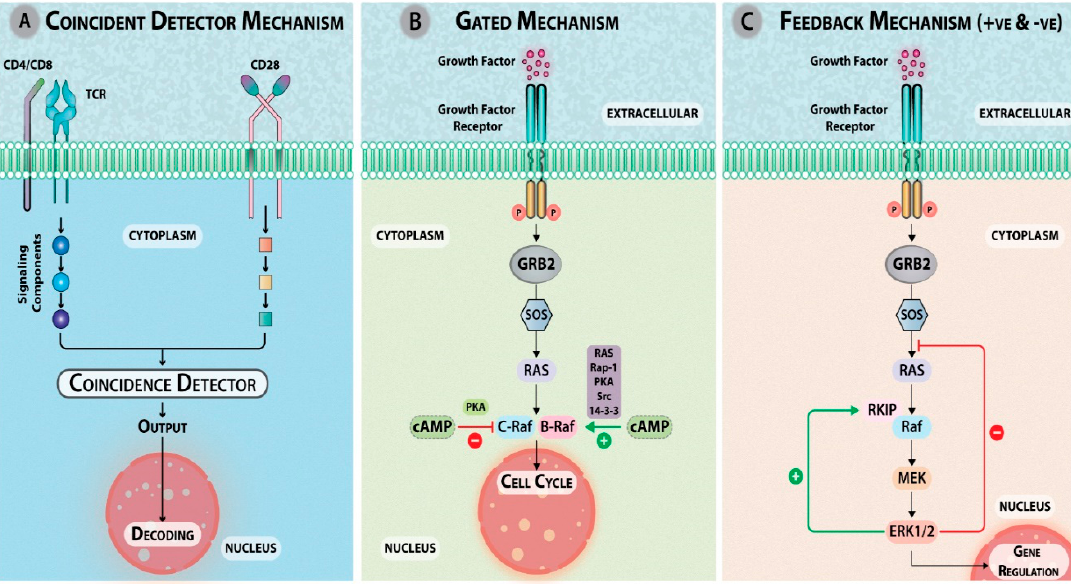
Figure 6. ( A ) In coincident detector mechanism; ( B ) gated mechanism; ( C ) feedback mechanism (positive and negative).